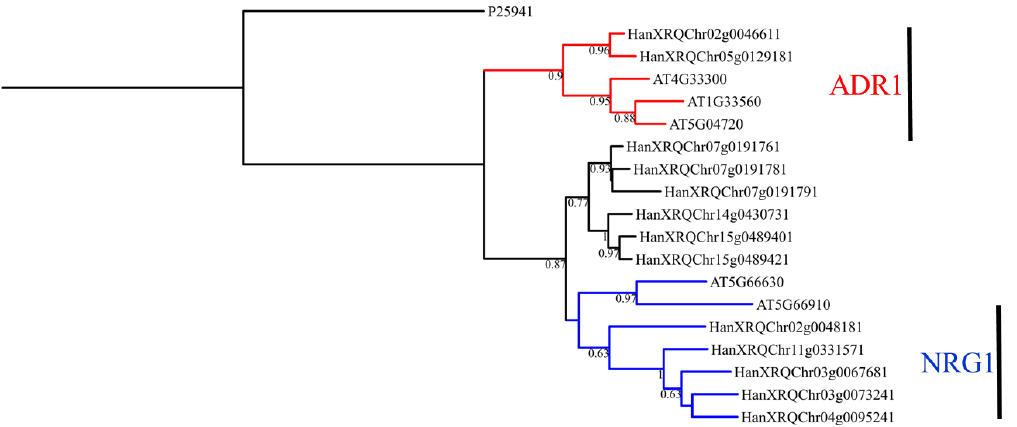
Figure 5. Phylogenetic relationships of RNL proteins in Arabidopsis thaliana and Helianthus annuus . The clades N-required gene 1 ( NRG1 ) and activated disease resistance gene 1 ( ADR1 ) are color-coded in blue and red, respectively. The tree was rooted using Streptomyces coelicolor NBS-containing protein, P25941, as an outgroup.